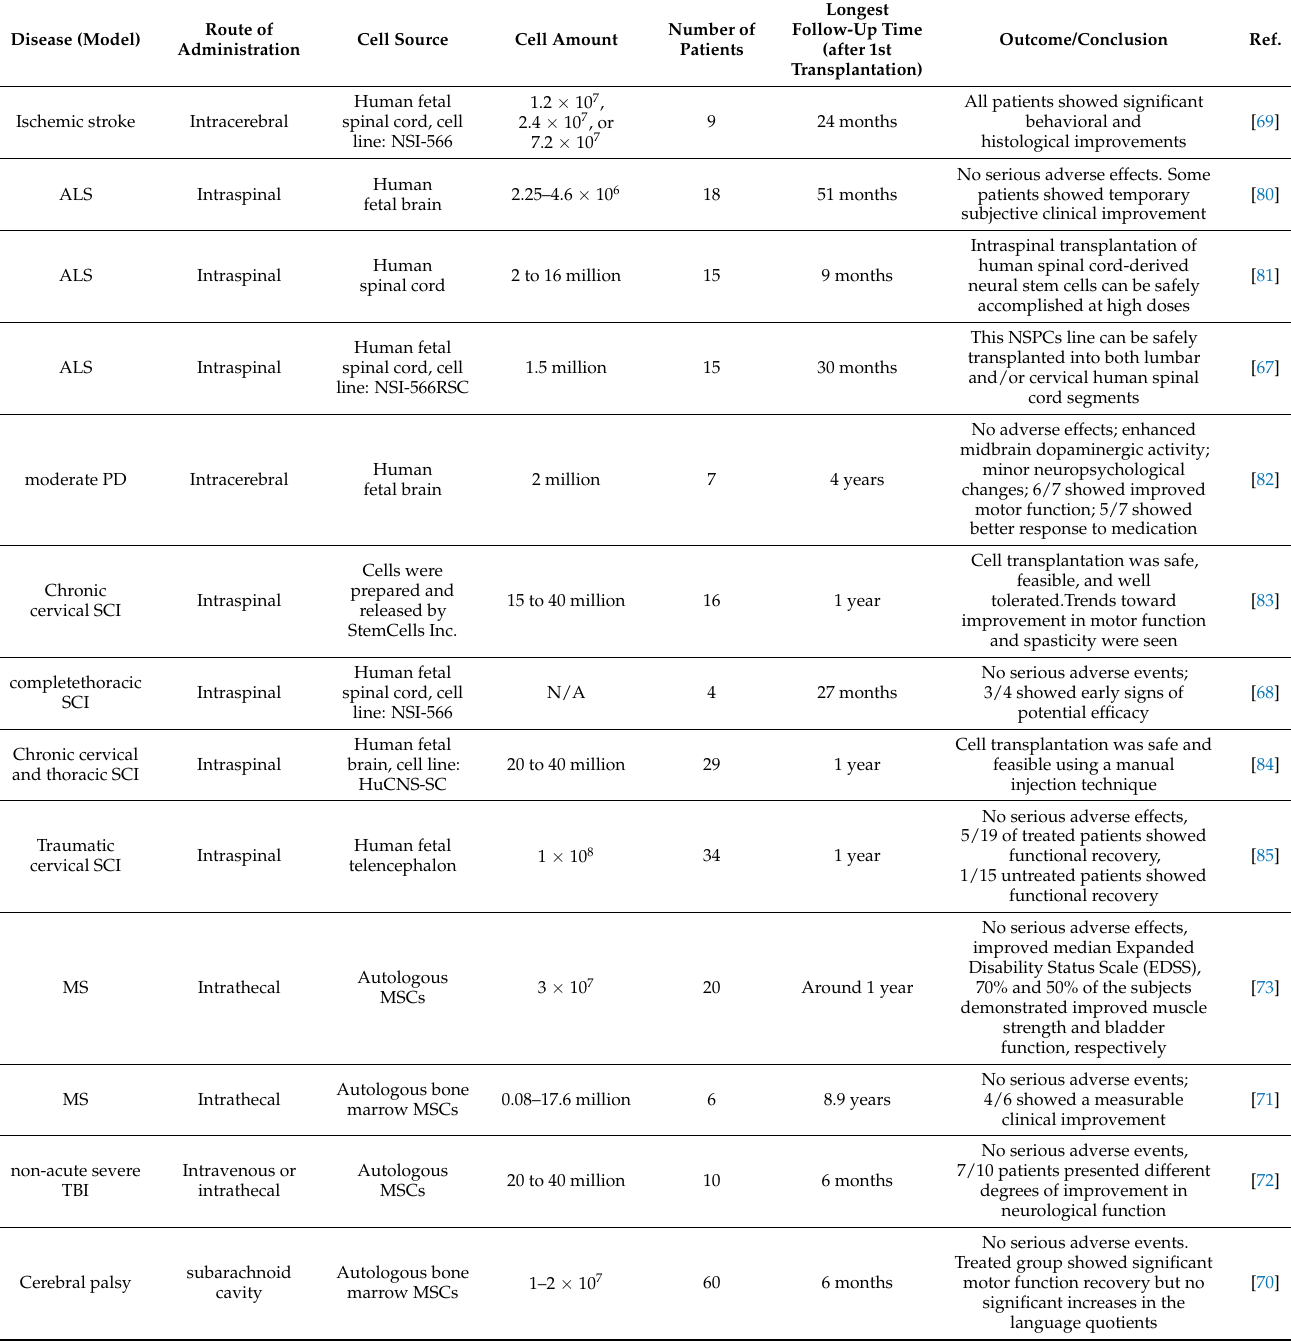
Table 3. Examples of hNSPC transplantation for neurological disorders in clinical trials (data from PubMed).